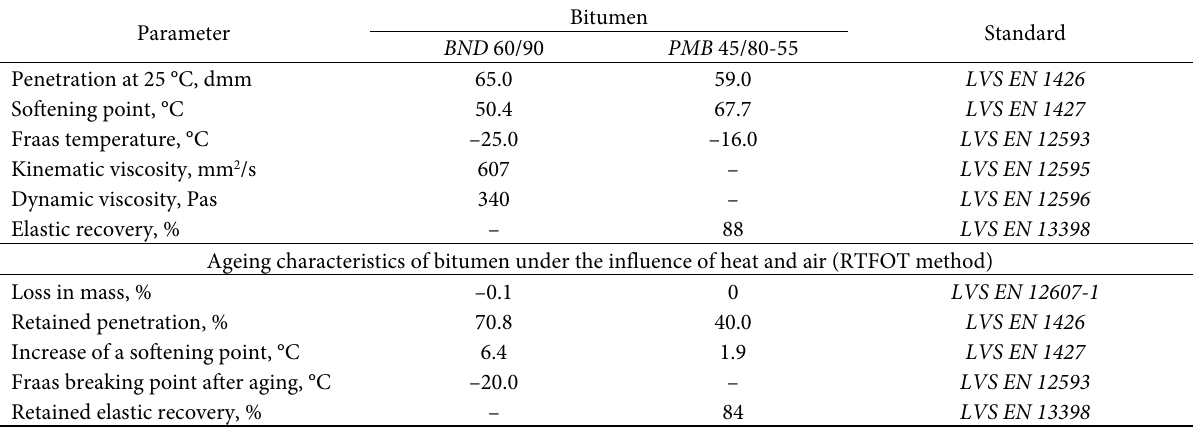
Table 4. Typical characteristics of the bitumen BND 60/90 and PMB